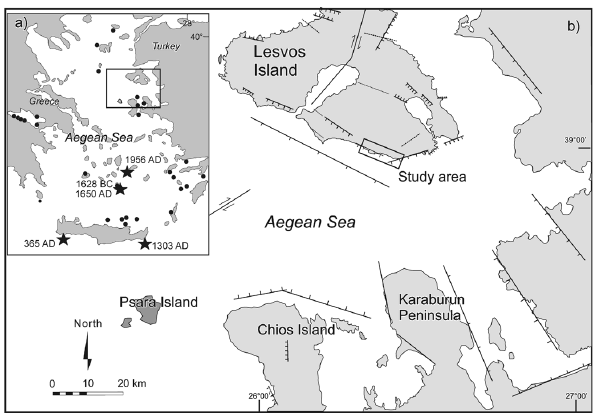
Fig. 1. (a) Indicative locations of historical tsunamogenic sources in the broad Aegean area according to Soloviev (1990); Yolsal et al. (2007) and Okal et al. (2009); black stars indicate location and year of the most destructive events. (b) Geographical location and simplified tectonic setting of the study area modified from Mascle and Martin (1990) and Pavlides et al.